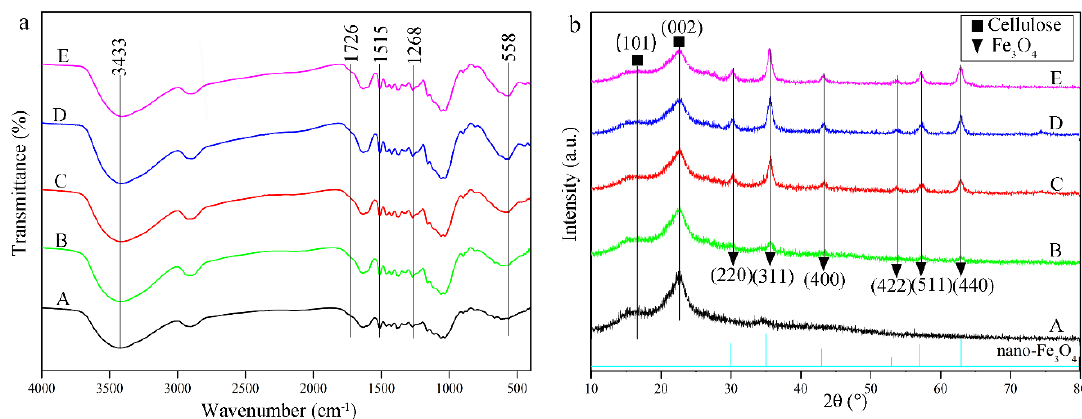
Figure 7. FTIR spectra ( a ) and XRD patterns ( b ) of binderless fiberboard and NFF binderless composite boards. (A. fiberboard; B. NFF1 board; C. NFF2 board; D. NFF3 board; E. NFF4 board.)